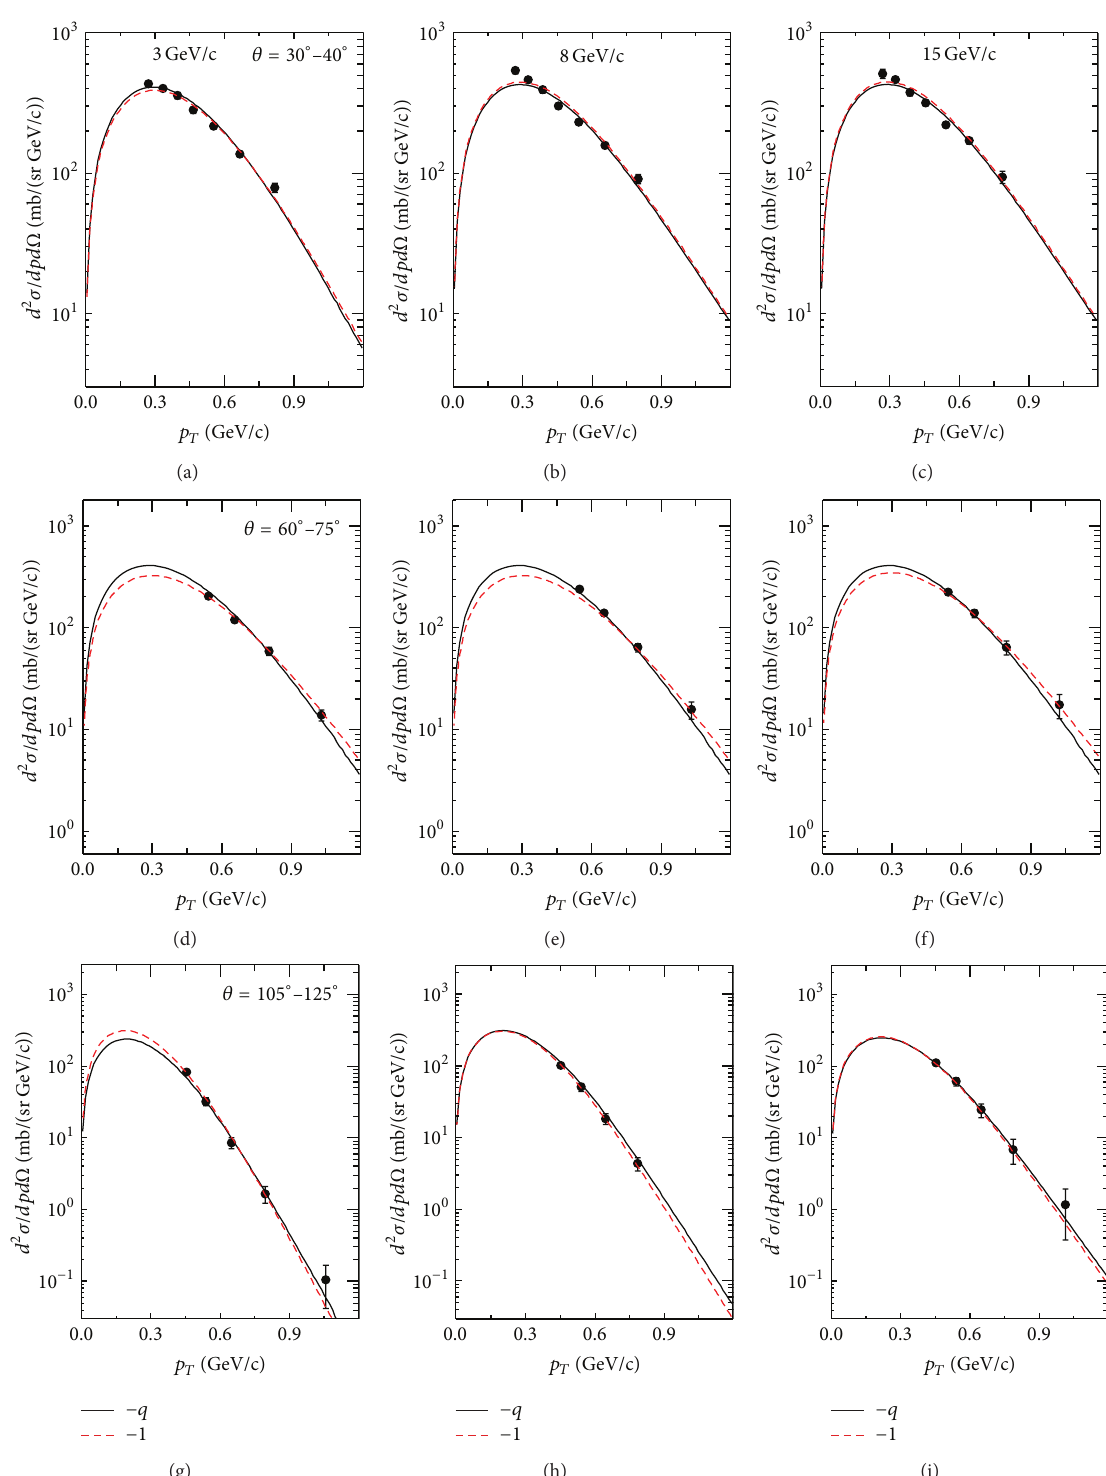
Figure 1: Transverse momentum spectra of protons produced in 𝑝 + Cu collisions at 3, 8, and 15 GeV/c at different angular intervals. The symbols represent the HARP-CDP experimental data [15]. The solid curves and dashed lines are the results calculated by (4) and (5),